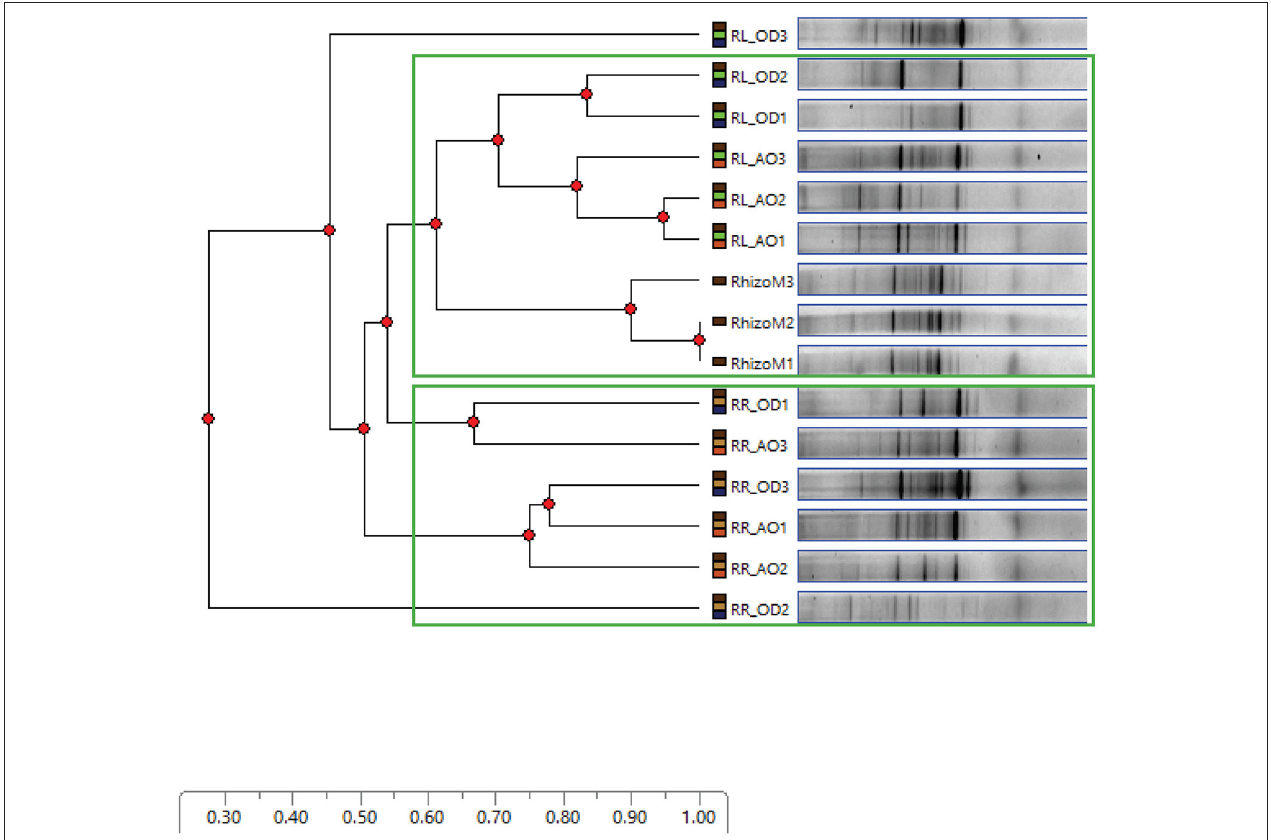
FIGURE 3 | DGGE bands obtained for sunflower endo-rhizosphere bacterial community, developed in MPN culture tubes of root segments (RR; ) or leaf strips-based (RL; ) culture media; UPGMA cluster analysis based on Euclidean distances of DGGE lanes. Each lane represents the growth harvested from one MPN culture tube, and each culture medium is represented by three MPN tubes (1–3), incubated under ambient oxygen (AO; ) or limited oxygen (OD; ) conditions. RhizoM ( ), DNA extracted from original suspension of plant roots